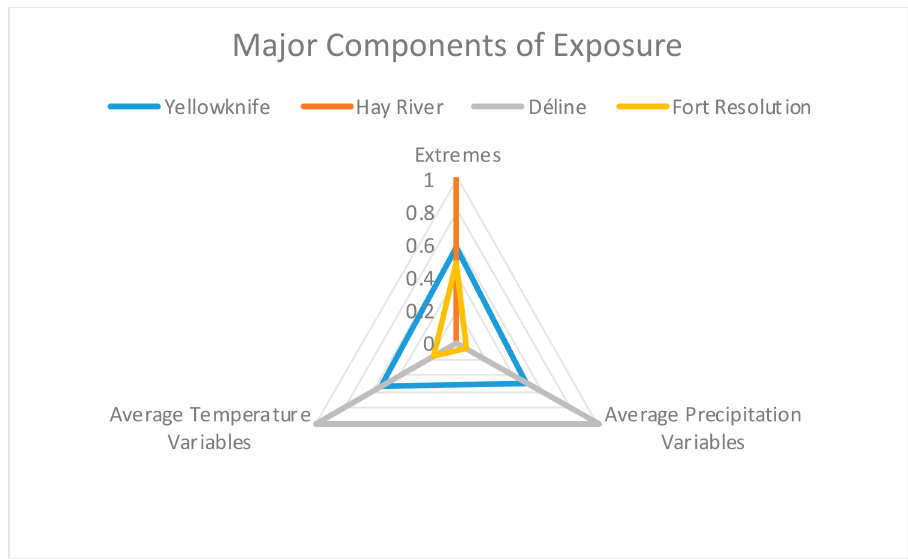
Figure 3. Each community’s exposure to the individual major components of exposure (extremes, average precipitation variables, and average temperature variables).